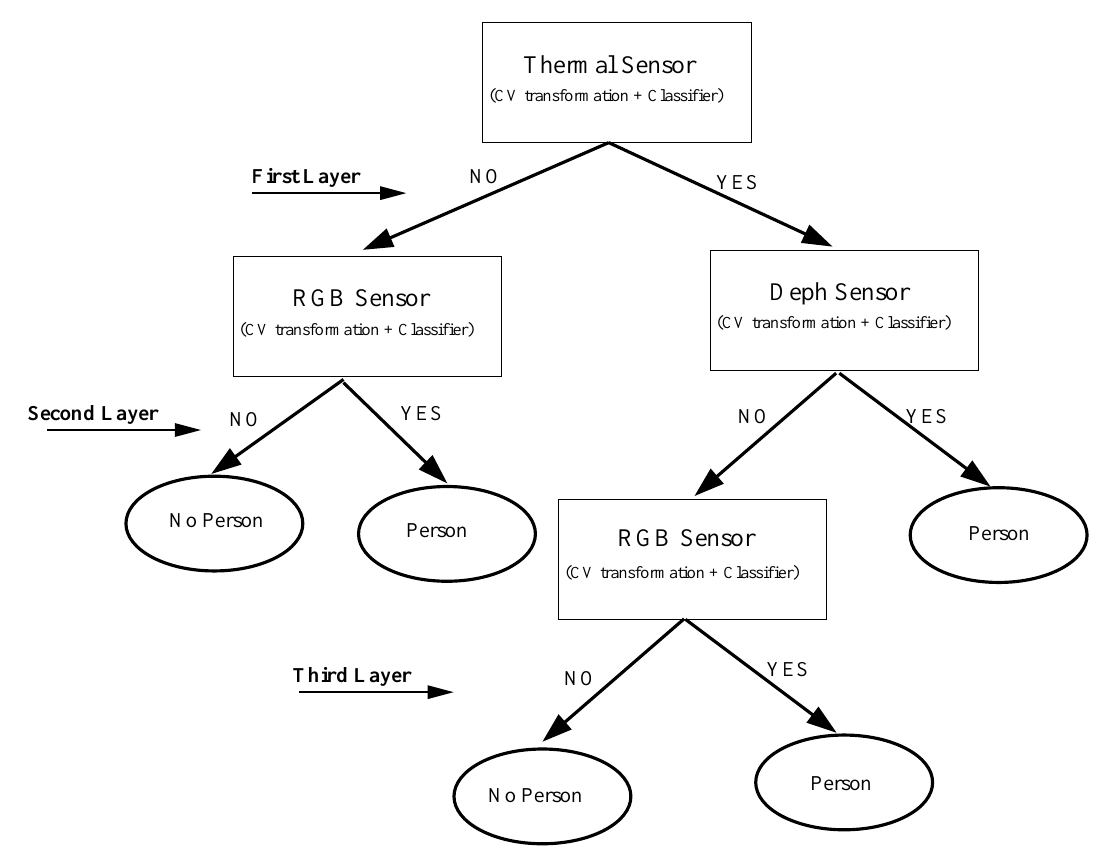
Figure 13. Example of a hierarchical classifier. Thermal